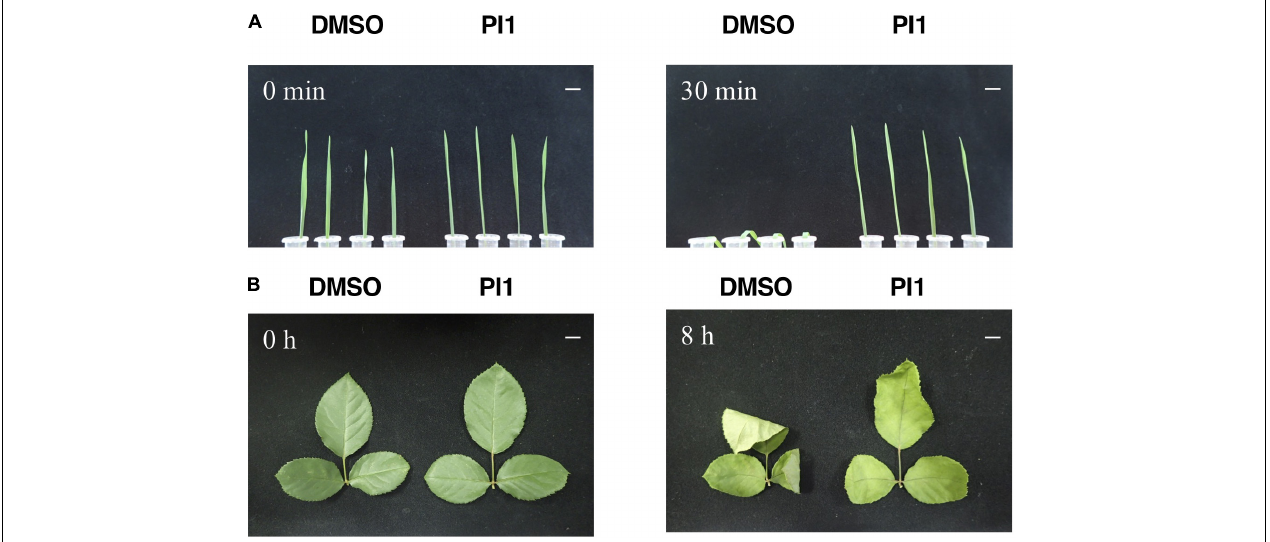
FIGURE 5 | Effect of PI1 on leaf wilting. Oat leaves (A) and rose leaves (B) . Ten-day-old oat seedlings grown in soil (A) and rose leaves in bouquets (B) were sprayed with 100 µ M PI1 or an equal volume of DMSO in 0.05% Approach BI and 0.02% Silwet L77 and incubated under white light (50 µ mol m − 2 s − 1 ) and 70% relative humidity at 24 ◦ C for 3 h. Next, leaves were excised and incubated for 30 min (oat) and 8 h (rose) at 27 ◦ C under 50 µ mol m − 2 s − 1 at ∼ 40% relative humidity. Scale bars = 1 cm. Experiments were repeated on three different occasions with similar results.